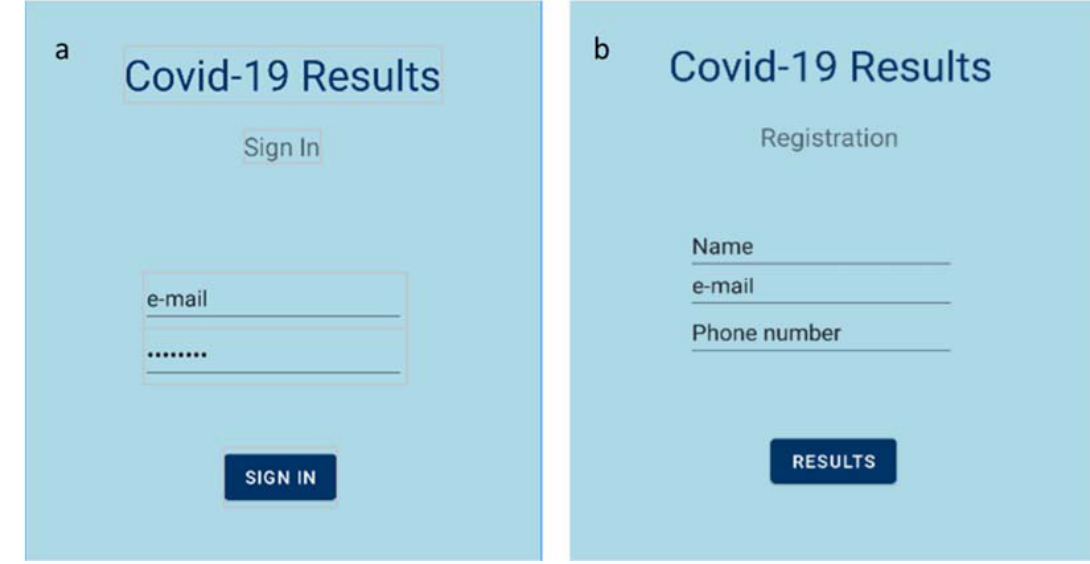
Figure 2. Mobile application’s homepage; ( a ) sign in page; ( b ) registration page.